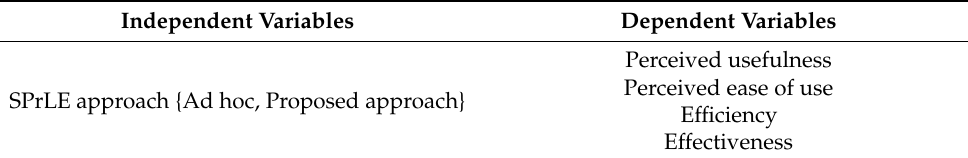
Figure 12. Experiment setup. Table 4. Independent and dependent variables in the experiment.